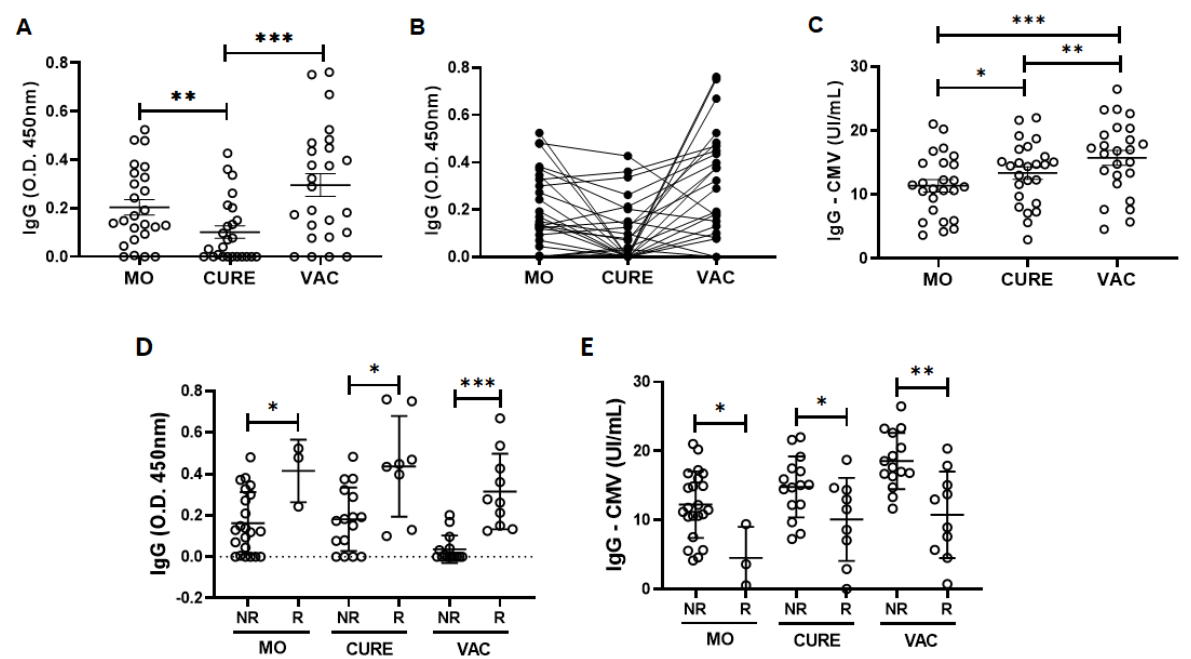
Figure 1. Total serum levels of IgG specific for SARS-CoV-2 (O.D. 450 nm—( A )) and CMV (UI/mL—( C )) antigens, and the dynamics of serum IgG levels for SARS-CoV-2 ( B ), in a group of older adults who participated in the study on three different occasions: during the micro-outbreak of SARS-CoV-2 infection (MO), 6–8 months after this infection (CURE), and 30 days after administration of the second dose of ChadOx-1 vaccine (VAC). Also presented here are the total serum levels of IgG specific for SARS-CoV-2 (O.D. 450 nm—( D )) and CMV (O.D. 450 nm—( E )) antigens when the volunteers were separated in accordance with the presence (R—responders) and not (NR—non-responders) of neutralizing antibodies for SARS-CoV-2. * denotes values of p < 0.05; ** p < 0.01; *** p < 0.001.